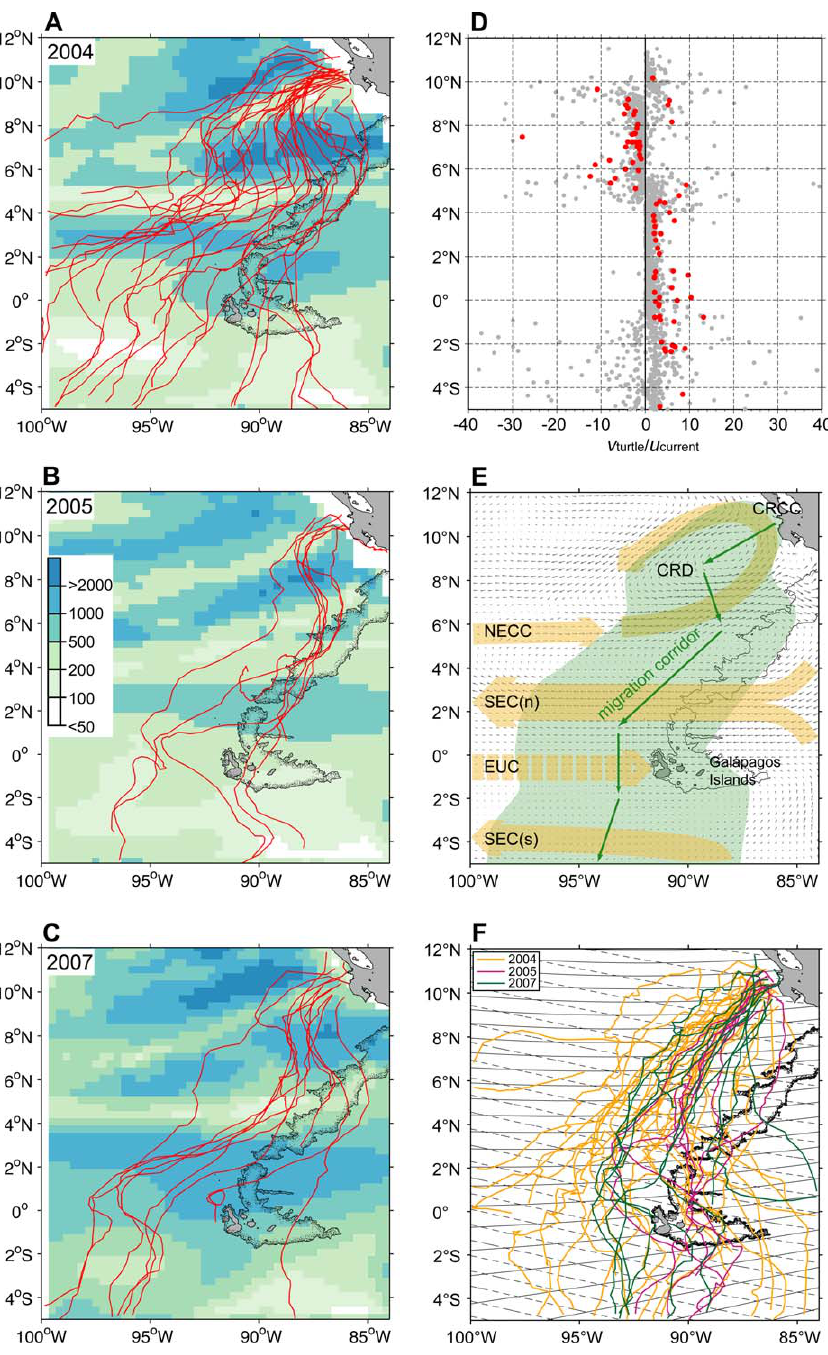
Figure 3. Leatherback Movements in Relation to Ocean Currents in the Migration Corridor Region (A–C) Turtle tracks overlaid on MKE (in cm 2 s (cid:2) 2 ) for February–April periods for 2004, 2005, and 2007. Stippling shows the 2000-m isobath highlighting the Cocos Ridge. (D) Ratio of turtle meridional velocity to current zonal velocity in the migration corridor region. Points corresponding to turtle meridional velocities faster than (cid:2) 70 km d (cid:2) 1 are colored in red. (E) Schematic of turtle migration corridor through the equatorial current system (current abbreviations are given in the text), based on the 75% home- range utilization distribution contour. (F) Current corrected turtle tracks from 2004 (orange), 2005 (green), and 2007 (purple), overlaid on contours of magnetic force (solid thin black lines) and magnetic inclination (dashed thin black lines). The force field has an intensity ranging from 38,314 nT in the north to 27,798 nT in the south, and contours are drawn every 420 nT. The inclination field ranges from 1.6 8 and 43.1 8 , and contours are drawn every 1.7 8 .